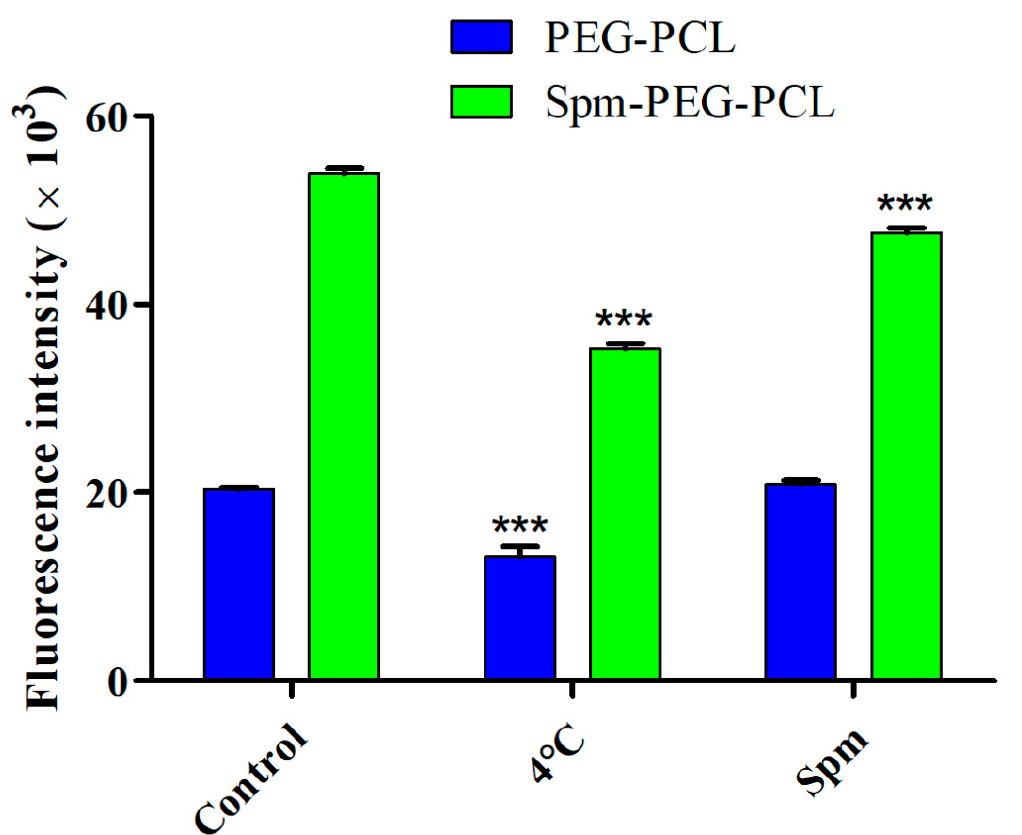
Figure 9. The cellular uptake mechanisms of Spm-modified micelles were studied by flow cytometry. Cellular uptake under 4 ◦ C pretreatment or in the presence of the competitive inhibitor Spm at 37 ◦ C for 1 h. Cells cultured without pretreatment were used as the control group ( n = 3). *** p < 0.001 compared to the control group. Table 5. Flow cytometry data for the mechanisms of micelle uptake (mean ± standard deviation, n = 3).